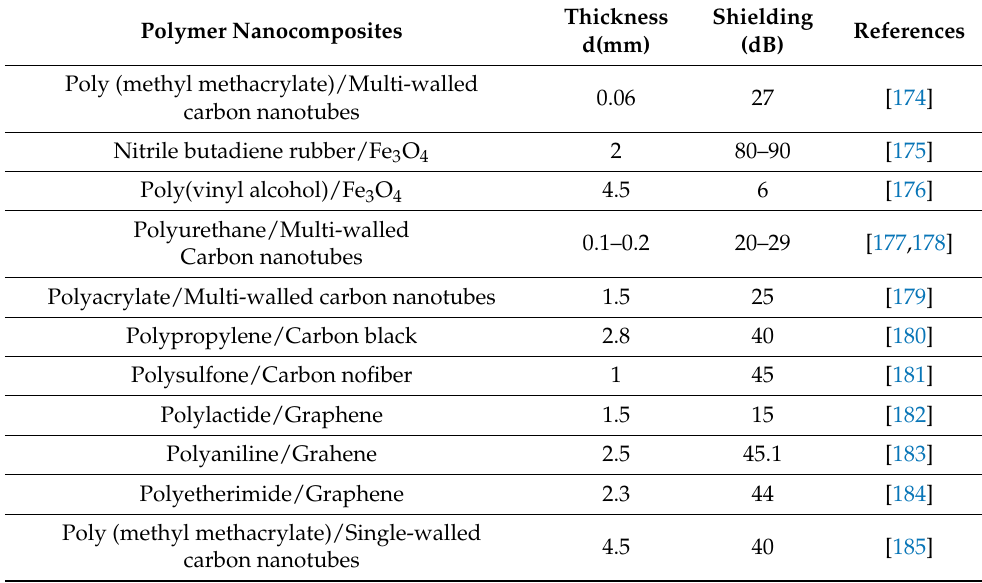
Table 4. Shielding performance of some lightweight polymer